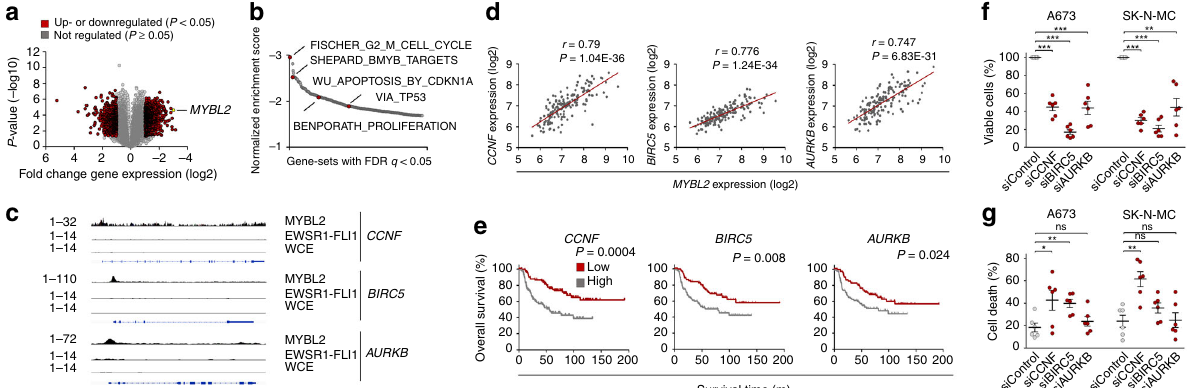
Fig. 3 MYBL2 mediates its phenotype via direct upregulation of CCNF , BIRC5 , and AURKB . a RNA-seq showing differentially expressed genes (DEGs) after siRNA-mediated MYBL2 knockdown compared to a non-targeting siControl. A summary of three cell lines is shown; n = 3 technical replicates per condition. b GSEA of RNA-seq data. Displayed are 275 gene-sets downregulated upon MYBL2 knockdown that had an FDR q < 0.05. c Analysis of MYBL2 ChIP-seq data from A673 cells showing MYBL2 peaks in the promoters of CCNF , BIRC5 , and AURKB . Publicly available EWSR1-FLI1 ChIP-seq data from A673 cells was analyzed to exclude a direct regulation by EWSR1-FLI1. Whole-cell extract (WCE) served as a control. d Linear regression of CCNF , BIRC5, and AURKB expression onto MYBL2 expression in 166 EwS tumors. e Kaplan – Meier survival analyses of 166 EwS patients strati fi ed by median expression levels of the indicated gene; P values determined via Mantel – Haenszel test. f Viable cell count 96 h after transfection of A673 and SK-N-MC cell lines with two different siRNAs directed against either CCNF , BIRC5 , or AURKB (summary of two different siRNAs shown) or a non-targeting siControl. Horizontal bars represent means, and whiskers represent the SEM, n ≥ 3 biologically independent experiments. g Measurement of cell death using Trypan blue positivity 96 h after transfection of A673 and SK-N-MC cells transfected as described in f . Horizontal bars represent means, and whiskers represent the SEM, n ≥ 3 biologically independent experiments. *** P < 0.001, ** P < 0.01, * P < 0.05; P values determined via two-tailed Mann – Whitney test. Source data are provided as a Source Data fi